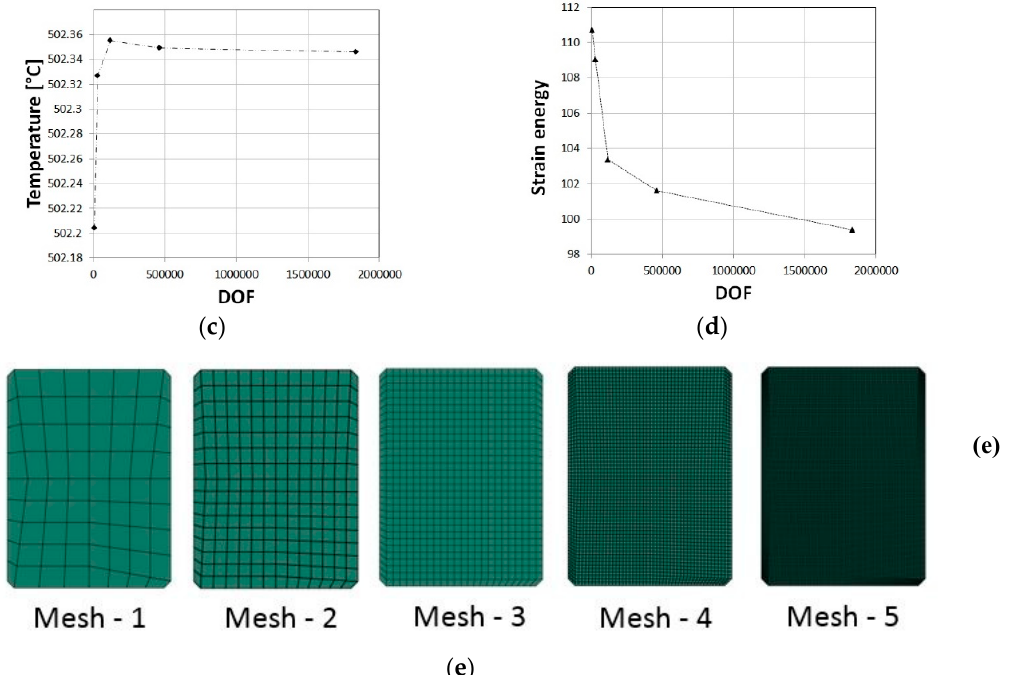
Figure A2. Verification of ring upsetting simulations: convergence in equivalent plastic strains ( a ), von-mises stress ( b ), and temperature ( c ). Convergence in strain energy values ( d ). Examples of the specimen mesh used in the convergence study ( e ).